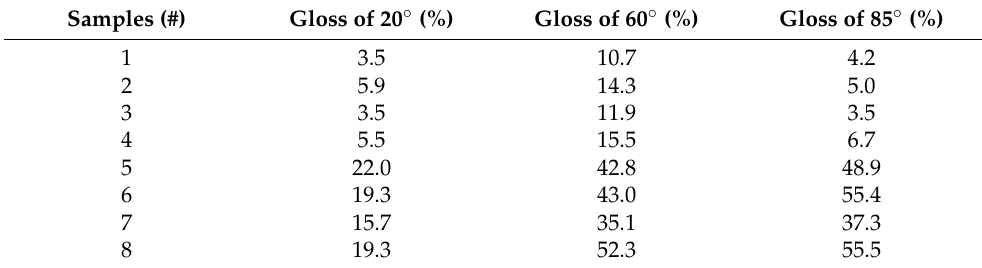
Table 4. Influence of coating processes on gloss of water-based coating containing microcapsules.